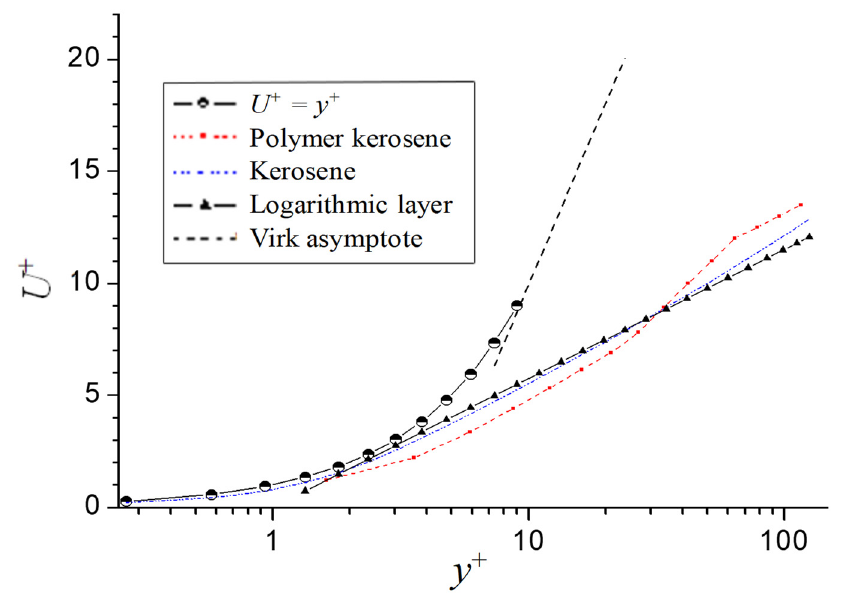
Figure 7. Dimensionless velocity distribution with wall distance for different flow boundary lay-